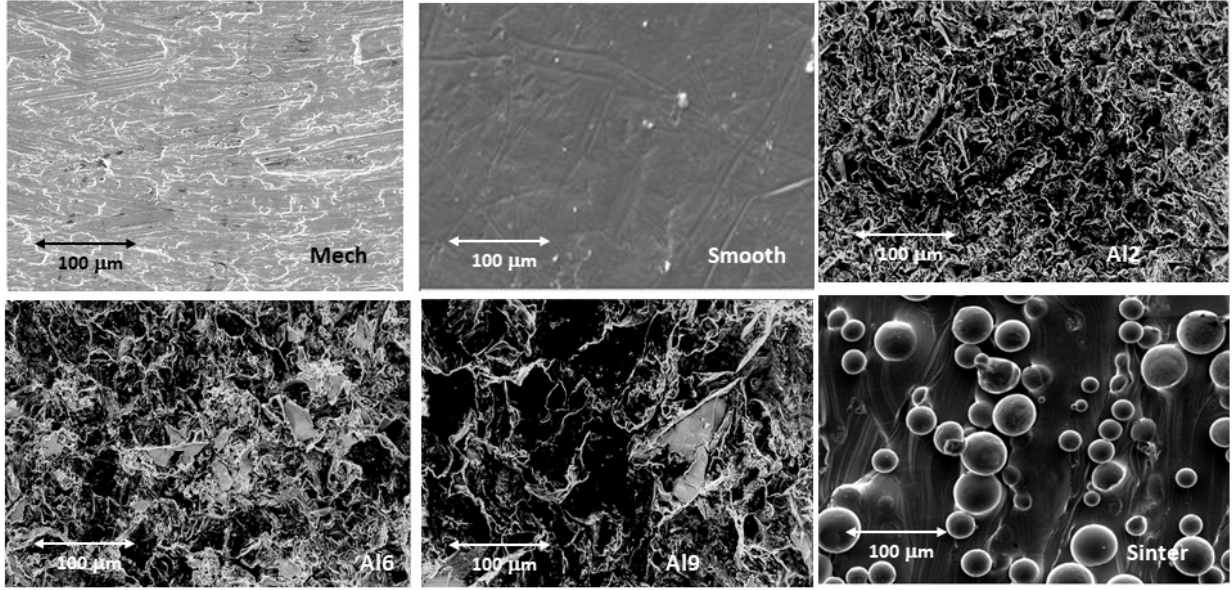
Figure 2. Surfaces observed by scanning electron microscopy with the same magnification for each treatment studied.